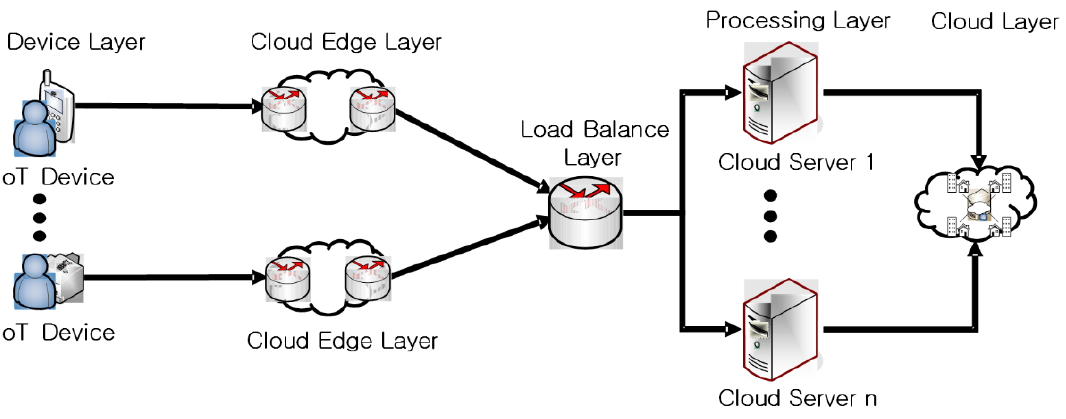
Figure 2. System layer